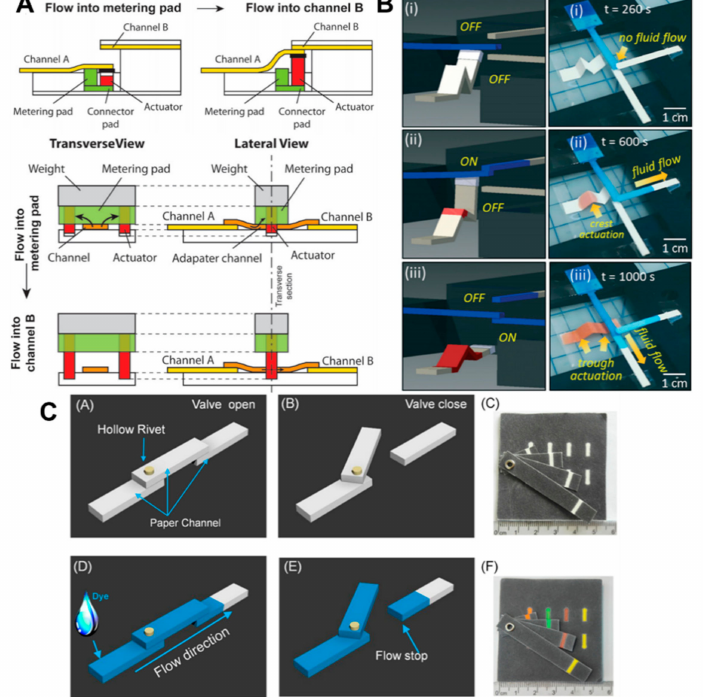
Figure 6. Flow control using mechanical-based methods. ( A ) Schematic of a volume-metered valve with a cantilever channel and moveable metering pad. In a cantilever channel, when the actuator is expended by the delivered fluid from the metering and connector pads, channels A and B are connected. In a moveable metering pad, as the solution flows through the metering pad, the actuator swells up to form space; then, the fluid flows into channel B (reproduced from ref [128] with permission from the Royal Society of Chemistry, 2015). ( B ) ( i ) Only blue dyed water flows through channel owing to the physical separation from other channels. ( ii ) When the red dyed water is dropped on the “W” shaped actuator, the tip of the actuator connects with the primary channel and the blue dyed water flows through the upper channel. ( iii ) The tip of the actuator connects with the bottom channel after trough actuation (reproduced from ref [129] with permission from the Royal Society of Chemistry 2017). ( C ) Schematics and experimental figures of the hollow-rivet-assisted movable valve paper